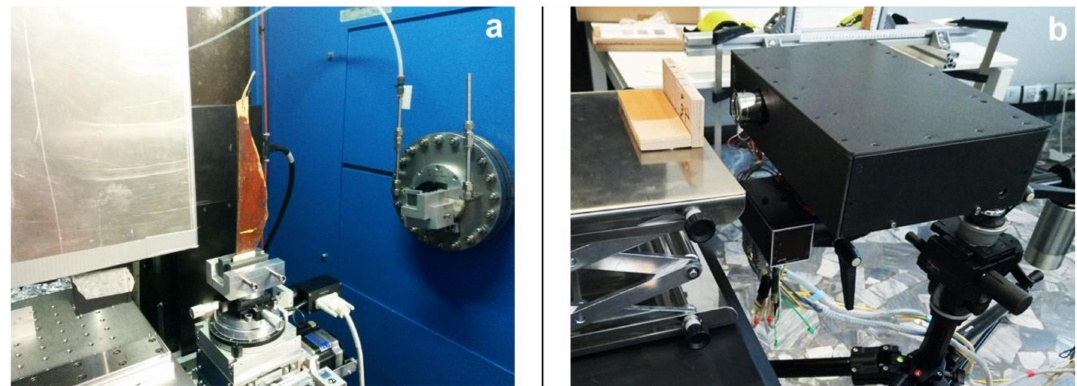
Figure 1. Tomographic setups: ( a ) high-resolution SR-micro-CT in phase-contrast mode at the SYRMEP beamline of the Elettra Synchrotron laboratory (Trieste, Italy); ( b ) prototype high-resolution portable Spectral domain optical coherence tomography (SdOCT) instrument built at N. Copernicus University for FP 7 CHARISMA project.